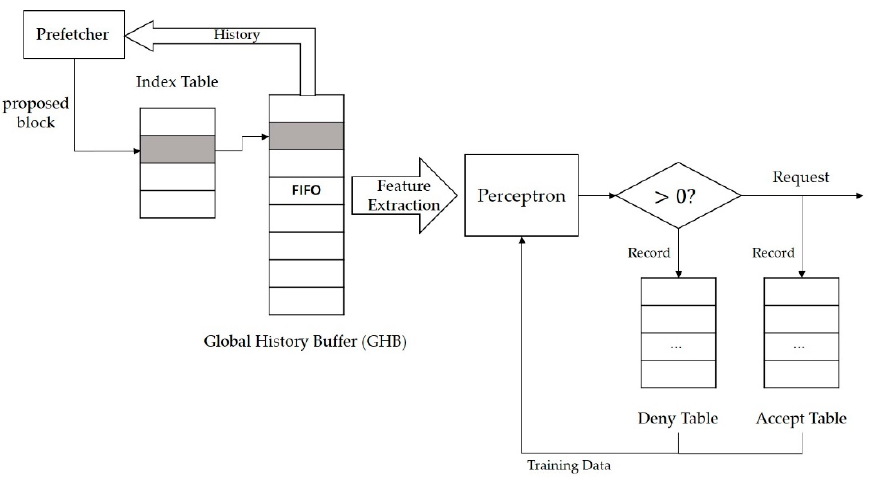
Figure 10. Two Level Prefetcher [13]: In the first level prefetcher, the feature related to the block proposed by the existing prefetcher is transferred to the perceptron, and in the second level prefetcher, the proposal is accepted or denied based on the value predicted by the